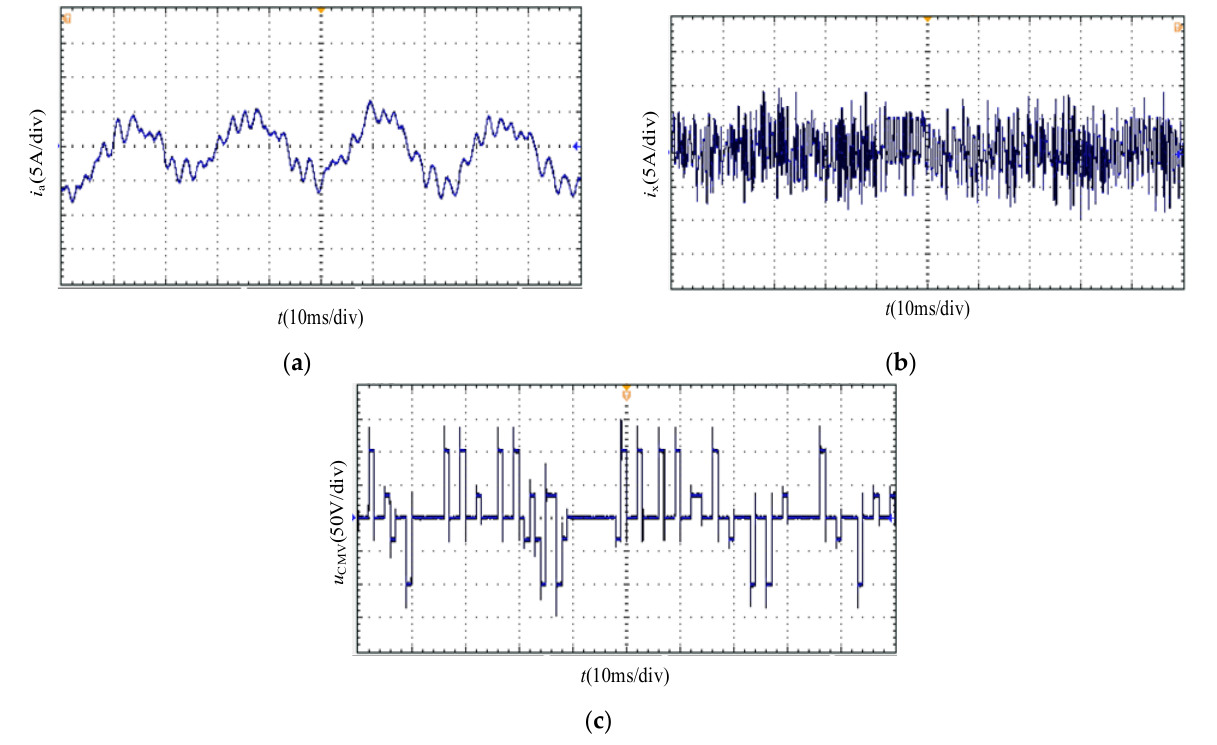
Figure 15. Steady experimental waveforms of traditional MPTC: ( a ) a-phase stator current; ( b ) har- monic current component i x ; ( c ) common-mode voltage.